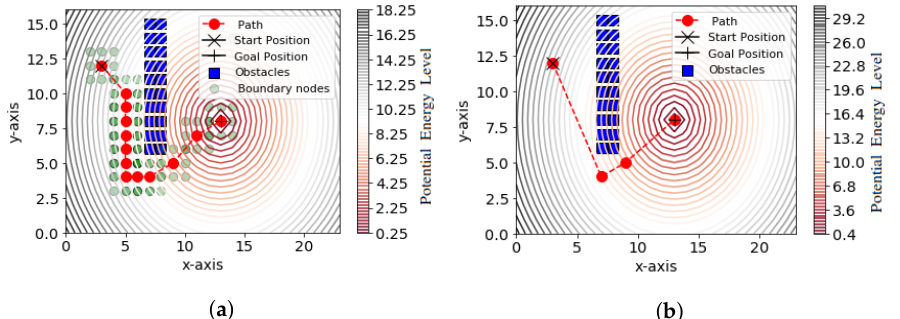
Figure 8. Example of path planning for a mobile robot [44]: ( a ) The obtained solution to IFP by using SW , where the sequence of the red circles represents the IFP. ( b ) The shortest path found by using PEM, where the solid red line represents the shortest